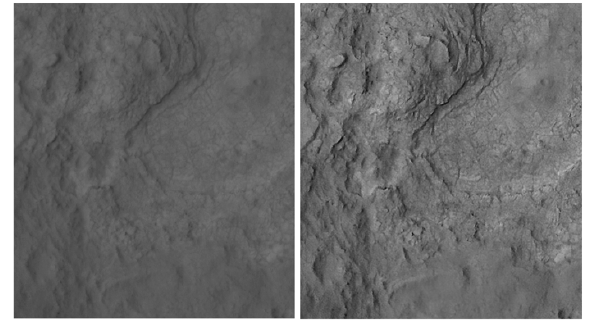
Figure 8 Example of 25cm HiRISE image ESP_028401_1755 (left) and 6.25cm SRR image (right) in the MSL Yellowknife bay and Shaler area.